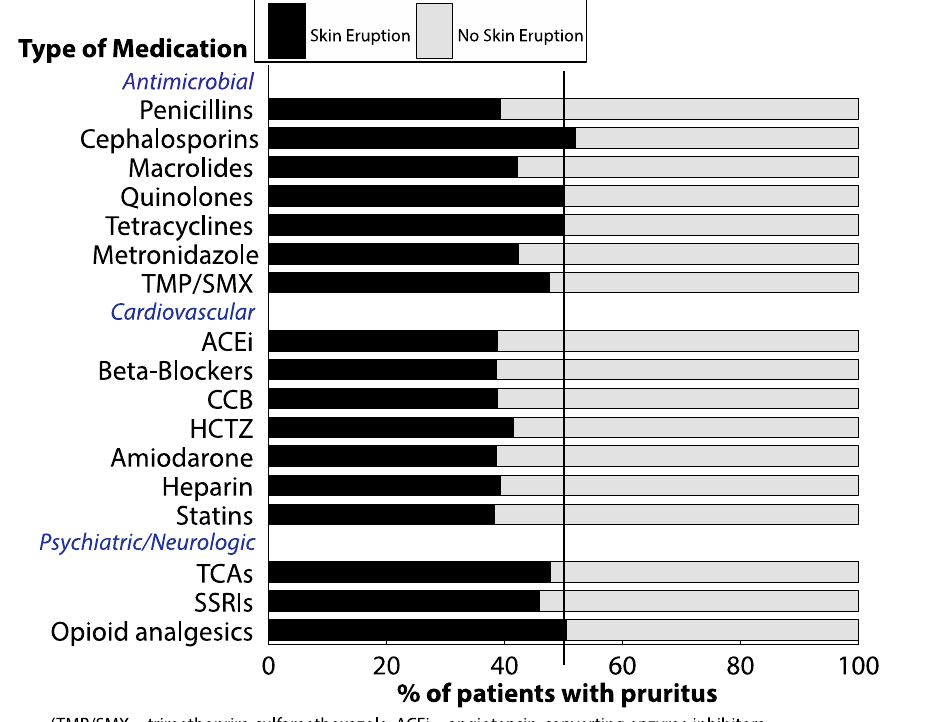
Figure 2. Frequency of skin eruption in patients with pruritus after receiving drugs .